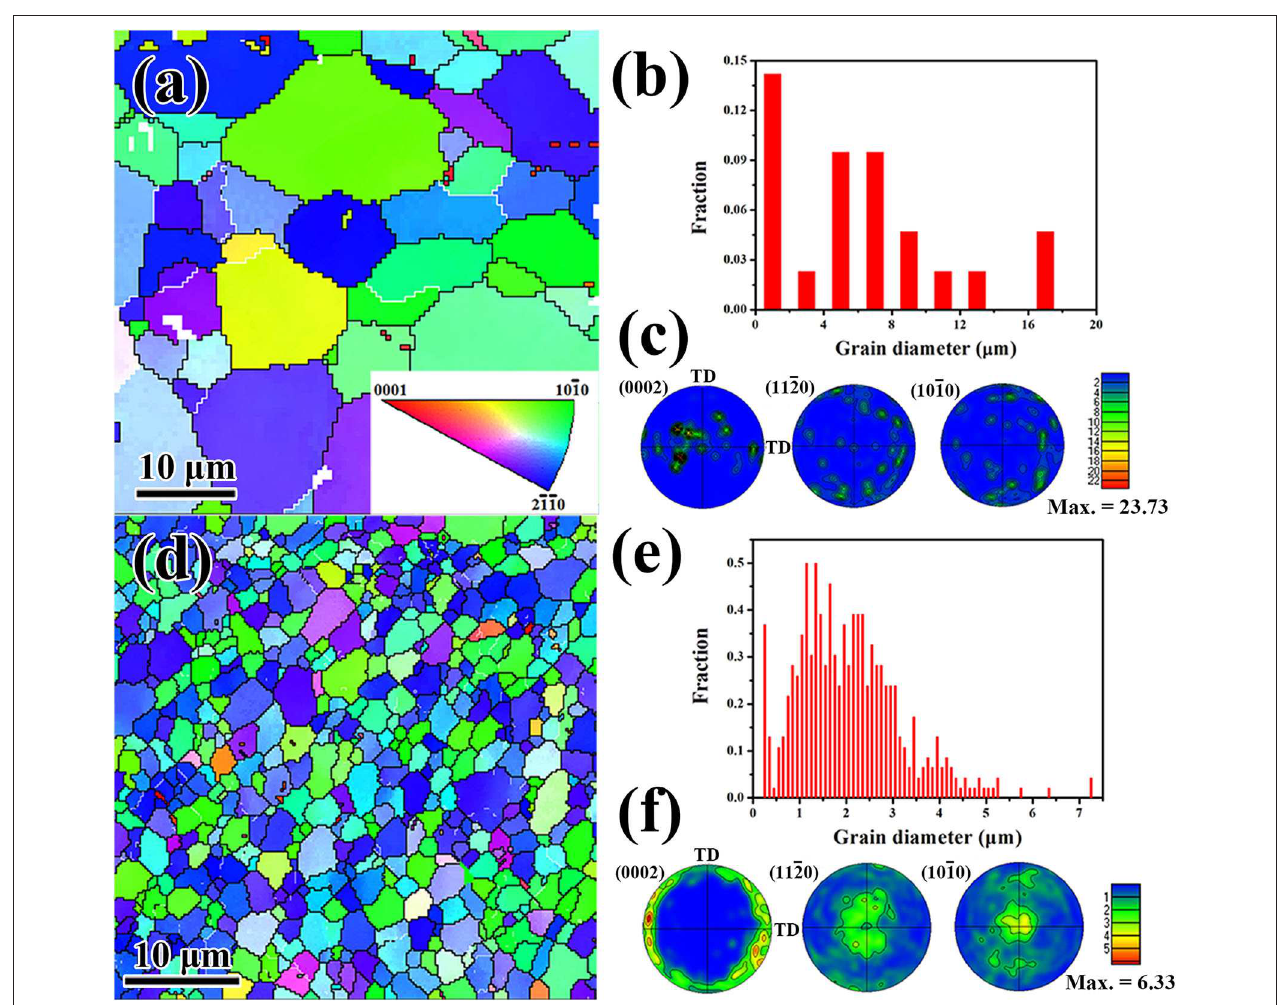
FIGURE 4 | Inverse pole figure maps of (a) as-extruded Mg − 1Sn alloys and (d) as-extruded Mg − 1Sn − 0.1Ti alloys. Grain size distributions of (b) as-extruded Mg − 1Sn alloys and (e) as-extruded Mg − 1Sn − 0.1Ti alloys. Textures of (c) as-extruded Mg − 1Sn alloys and (f) as-extruded Mg − 1Sn − 0.1Ti alloys. The extruson axis is parallel to the image